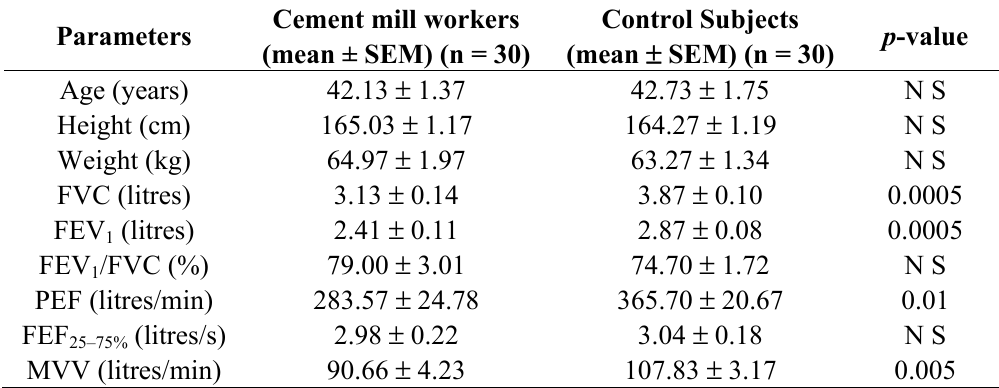
Values are presented as Mean ± SEM; NS =